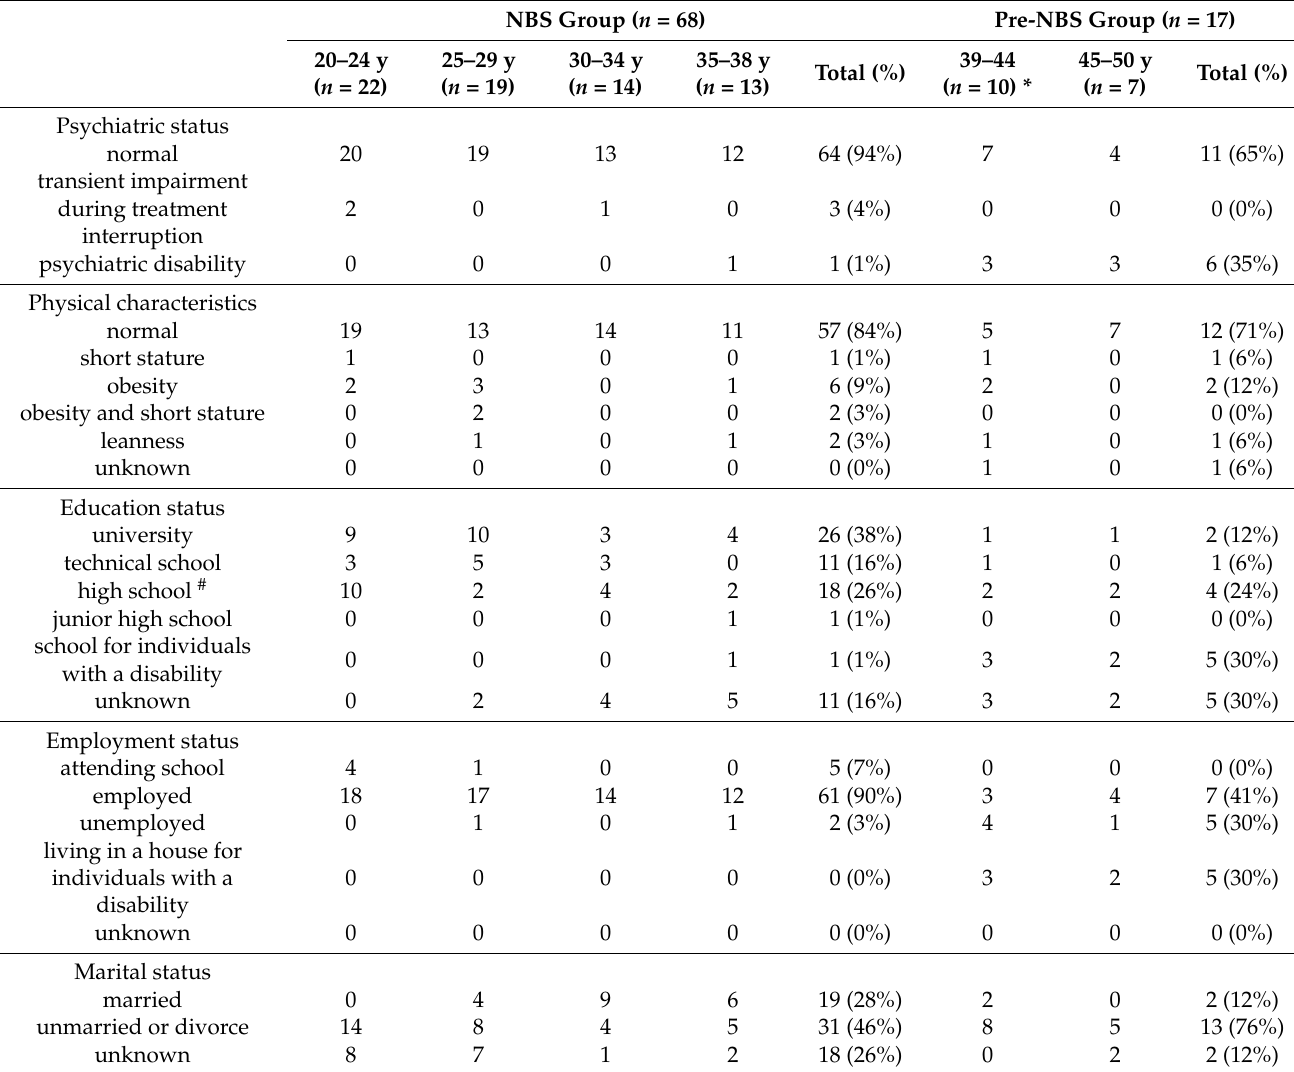
Table 3. Comparison of clinical and social